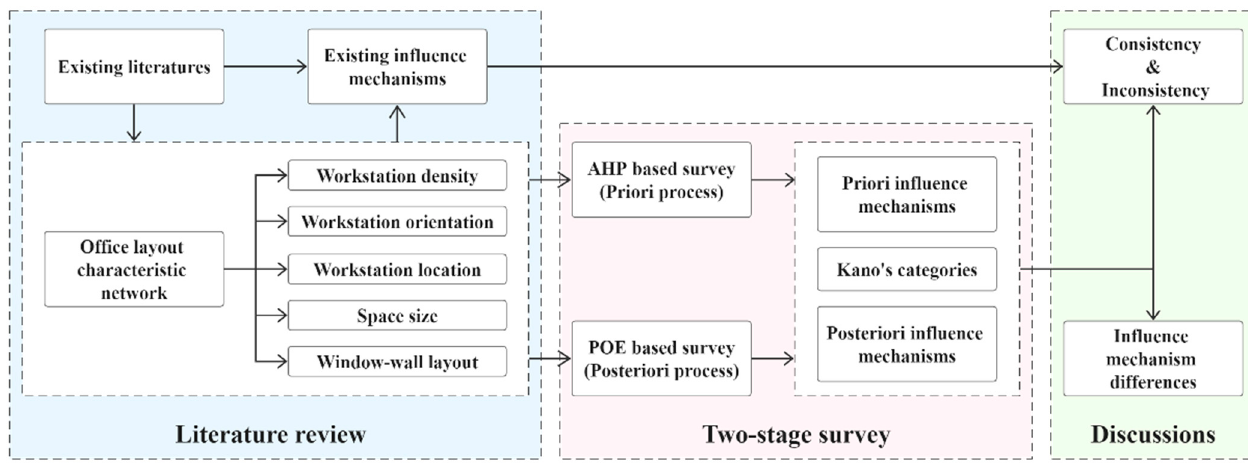
Figure 3. Overall methodology framework.